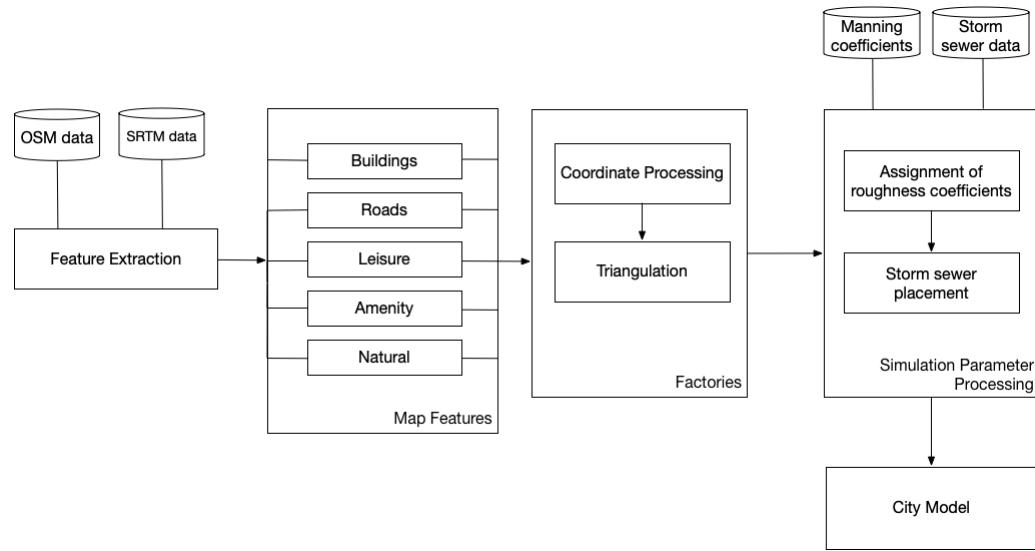
Figure 3. Processes City Maker utilizes to produce a city